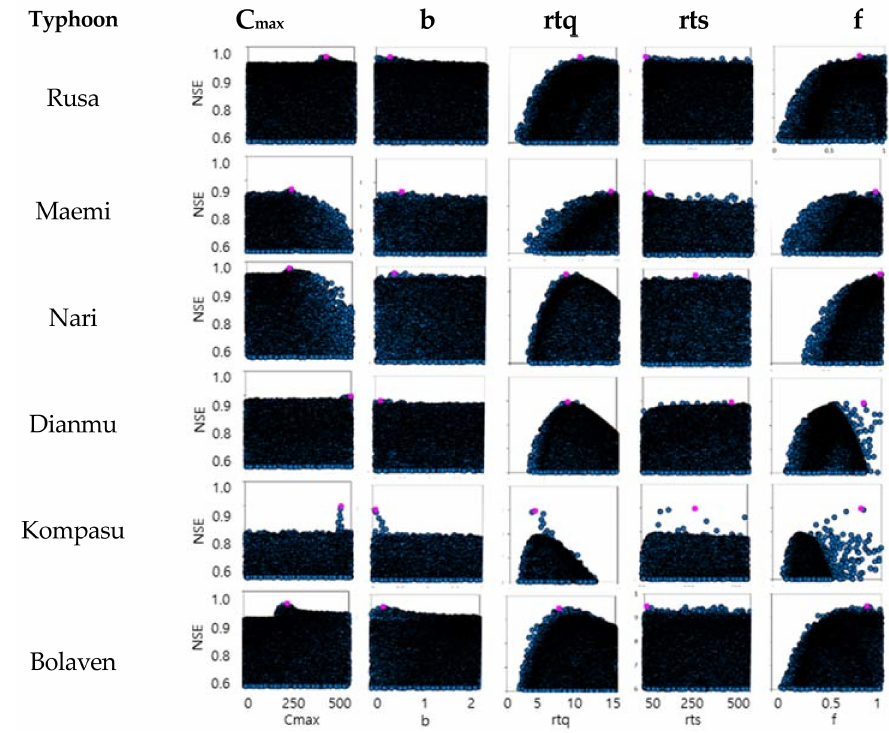
Figure 5. Scatter plots of calibration NSE against MP for each Typhoon flood events at C4.